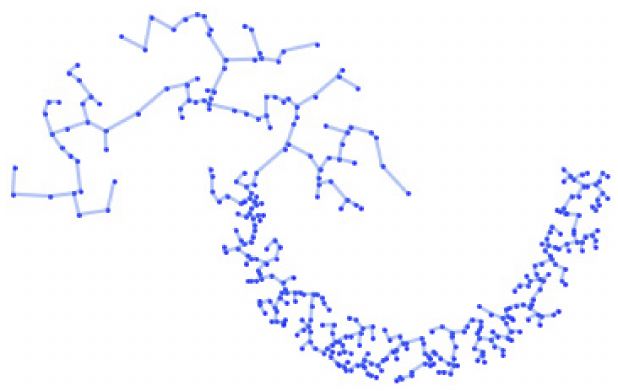
Figure 10. Network construction.